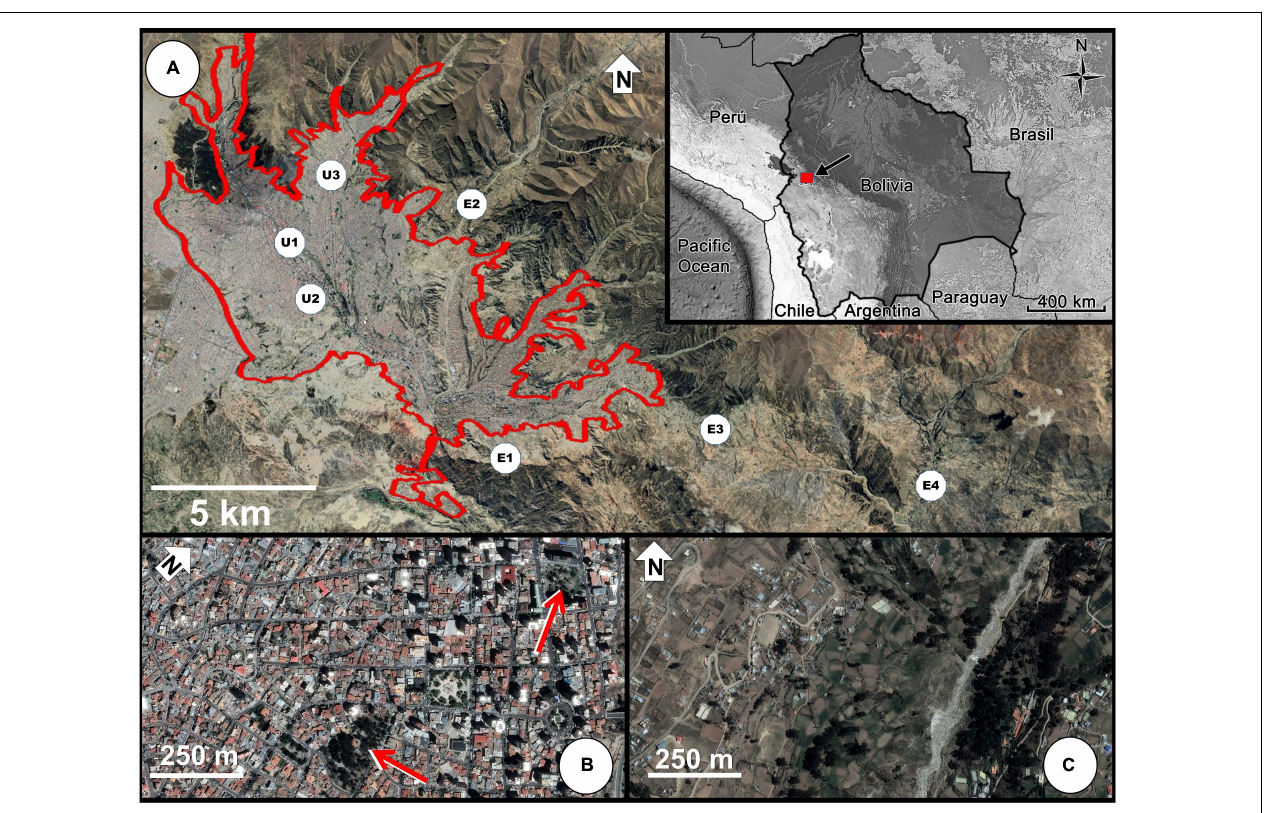
FIGURE 1 | Location of the study sites for behavioral studies of the Chiguanco Thrush in the city of La Paz (Bolivia). In (A) the city of La Paz with the limits of the urban fringe in November 2013 (red polygon), the upper right square details the position of the study area in the Bolivian Andes (solid red square); the position of the study sites is marked with white circles, U1 to U3 for the urban zone, and E1 to E4 for the extra-urban zone. Urban site U2 (B) and extra-urban site E2 (C) are shown in detail as examples of general landscapes. The red arrows in (B) mark the urban capture places for adult individuals. Satellite images from Google Earth Pro 7.3.2, 2019, (11/10/2013).